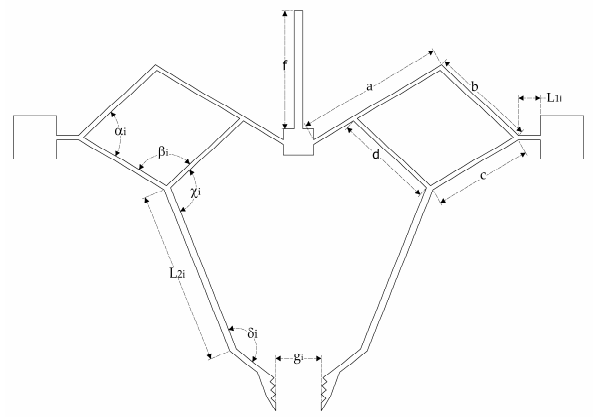
Figure 3. Schematic diagram of the initial gripper. Table 4. Initial microgripper dimensions.